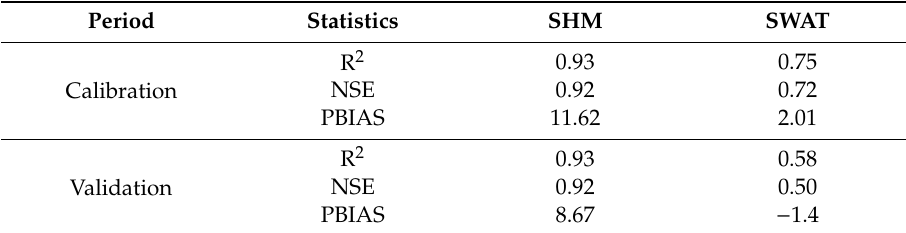
Table 2. Calibration and validation performances of the models at a monthly scale.